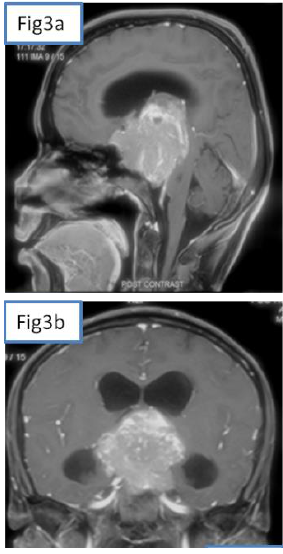
Figure 3a, b: T1W sagittal and coronal contrast MRI images showing 61 x 60 x 49 mm (Transverse x Coronary x Sagittal) sella-suprasellar mass extending into the suprasellar cistern and the third ventricle, causing obstruction of the 3rd ventricle and hydrocephalus, performed when the patient had symptoms in 2012.